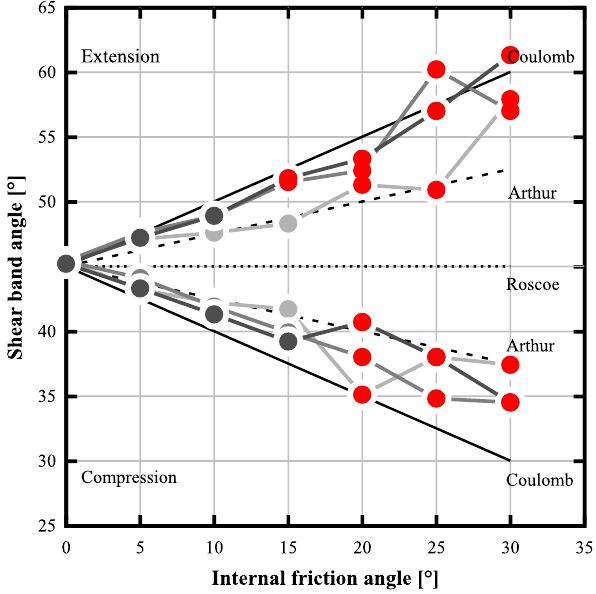
Figure 5. Measured shear band angle versus angle of internal fric- tion for models in tension and compression. Resolution runs from 256 × 64 (light grey line), to 512 × 128 (grey) to 1024 × 256 elements (dark grey). All models were run for 1000 NIs; red symbol runs cor- respond to the red line runs in Fig. 6. The black lines represent the theoretical angles of Coulomb (solid), Arthur (dashed) and Roscoe (dotted). We have corrected one of the automated shear band angle measurements manually – that of the 1024 × 256element extension case with φ = 25 ◦ – because it was computed using two different shear bands.